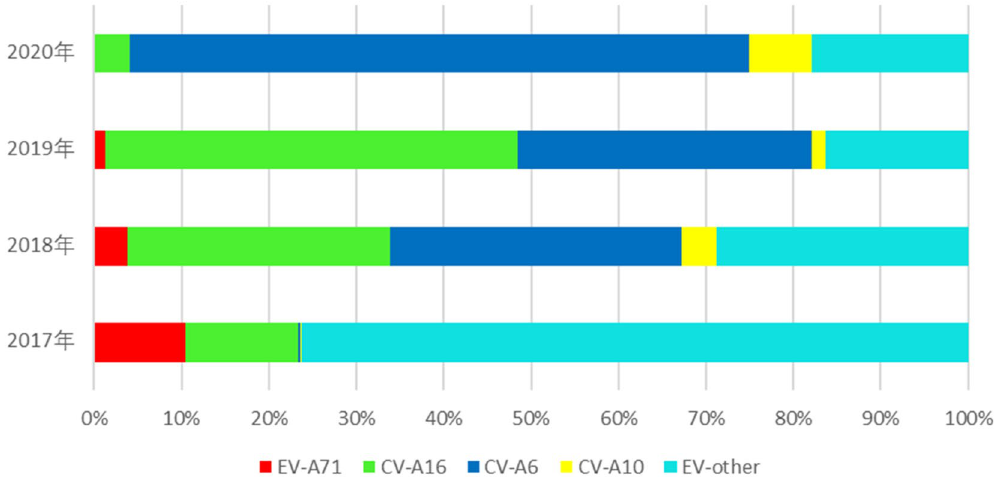
Figure 1. The annual percentages of positive enteroviruses of HFMD in Kunming, 2017–2020.